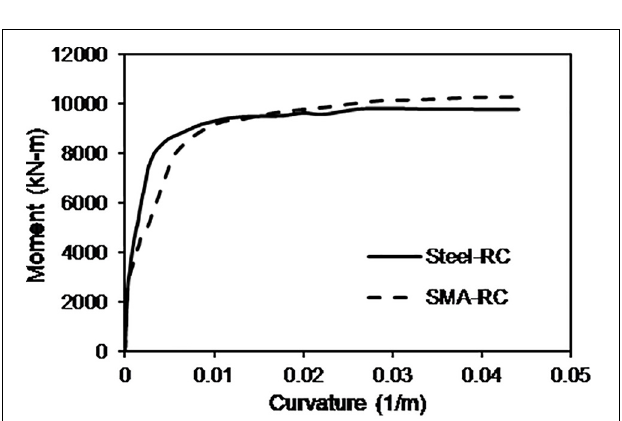
FIGURE 6 | Moment curvature relationship of steel-RC and SMA-RC section.